Question: Describe this figure in one sentence.
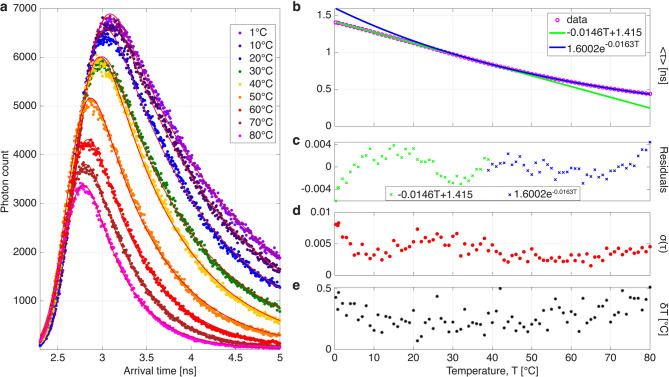
Answer: Excited-state lifetime of Cy5 as function of temperature. ( a ) Exemplified lifetime histograms of Cy5 in water acquired on an Abberior Expert line CLSM at different temperatures (color code, upper right) individually fitted with monoexponential decay functions convolved with a gaussian approximation for the instrument response function. ( b ) Mean excited-state lifetime ( τ ) of Cy5 as a function of temperature (N = 4 independent experiments; cyan circles), fitted with a linear model over 0–39 °C (green line) and a monoexponential model over 40–80 °C (blue line). ( c ) Residuals in both fit-regimes: linear (green symbols), monoexponential (blue symbols) ( d ) Standard deviation ( σ ) of fitted lifetime across experiments (N = 4). ( e ) Uncertainty ( δ ) of temperature measurement calculated from 2 σ in lifetime of individual experiments (N = 4).